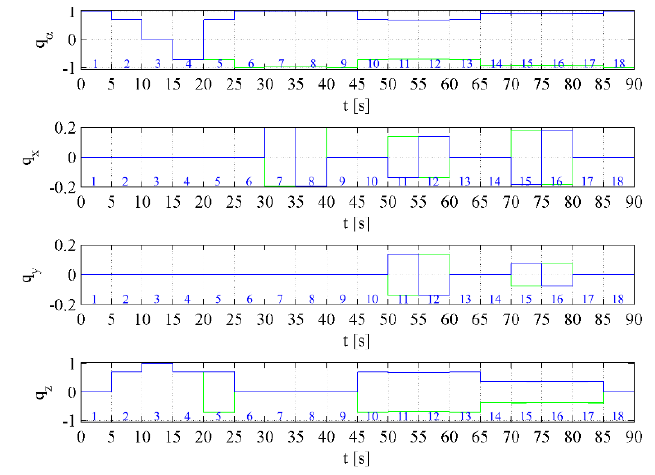
Figure 10. Sequence of desired orientation represented using quaternion.